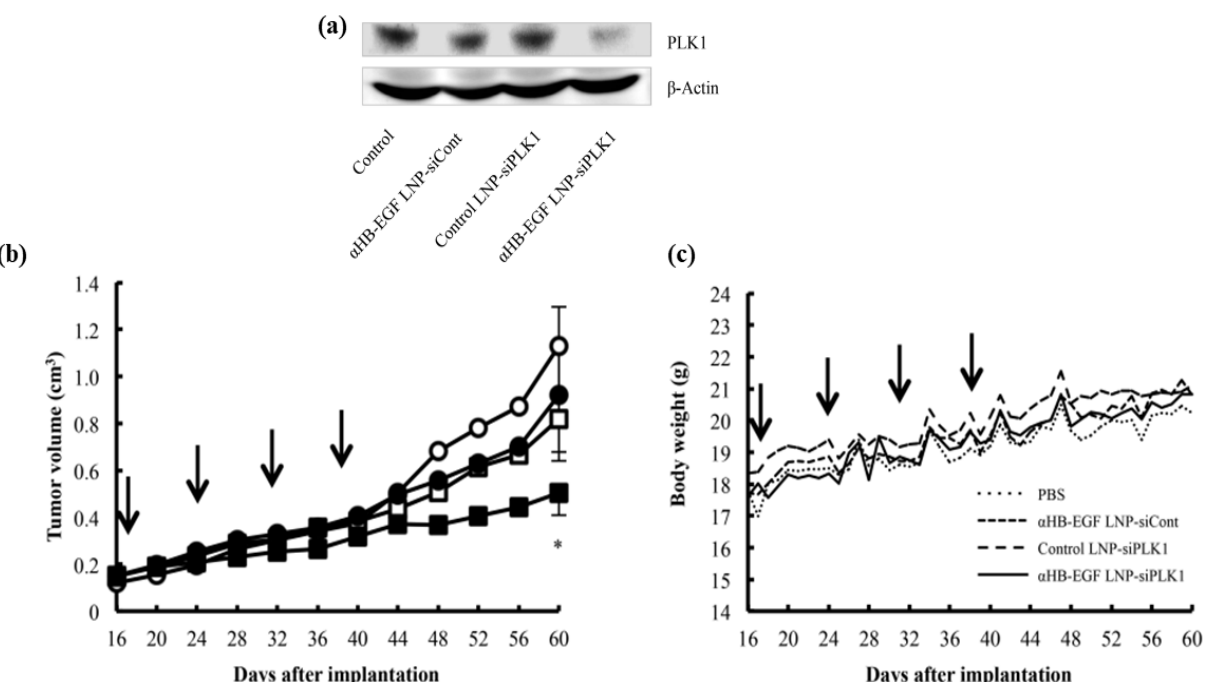
Figure 7. ( a ) Gene silencing activity of α HB-EGF LNP-siPLK1 in vivo study. MDAMB-231 carcinoma-bearing mice were injected via the tail vein with α HB-EGF LNPsi Cont, Control LNP-siPLK1, or α HB-EGF LNP-siPLK1. After treatment, the tumour was homogenized on the 5th day. Using the Western blotting technique, PLK1-protein expression was determined. ( b ) Anticancer effect of α HB-EGF LNP-siPLK1 in vivo. Once a week the mice with MDA-MB-231 carcinoma were injected four times with PBS ( ○ ), α HB-EGF LNP-siCont ( □ ), Control LNP-siPLK1 ( ● ), or α HB-EGF LNP-siPLK1 ( ■ ). The size of the tumour for each mouse was monitored from day 16. The days of treatment are indicated with arrows. The asterisk represents the significant difference (* p < 0.05 vs. PBS). ( c ) Monitored body weight of treated mice. Adapted with permission from ref. [173], Mol. Pharm. 2018.